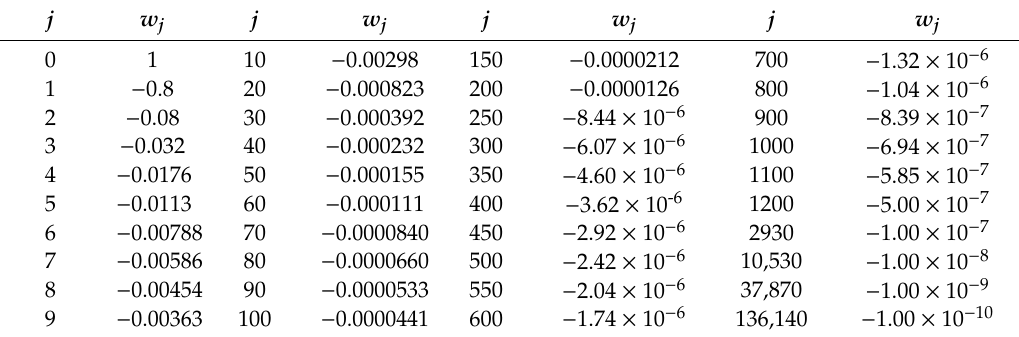
Table 1. Partial binomial coe ffi cients for α = 0.8.